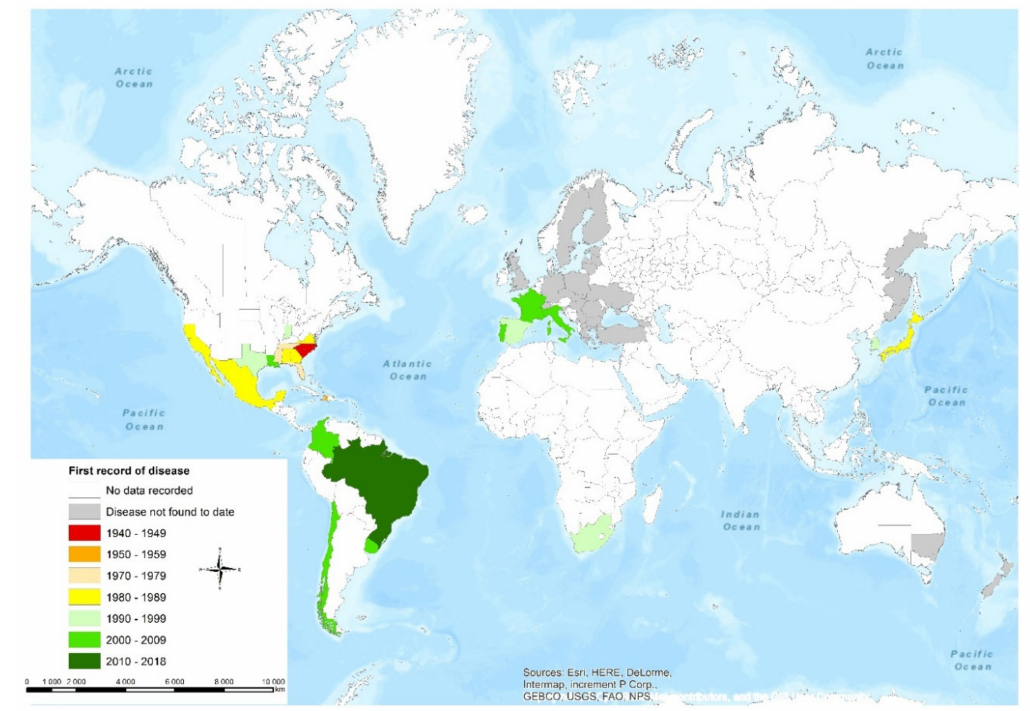
Figure 1. Historical dispersal of Fusarium circinatum according to the date the pathogen was first recorded in the country (see Table 1 for details). The data are based on literature and monitoring records.